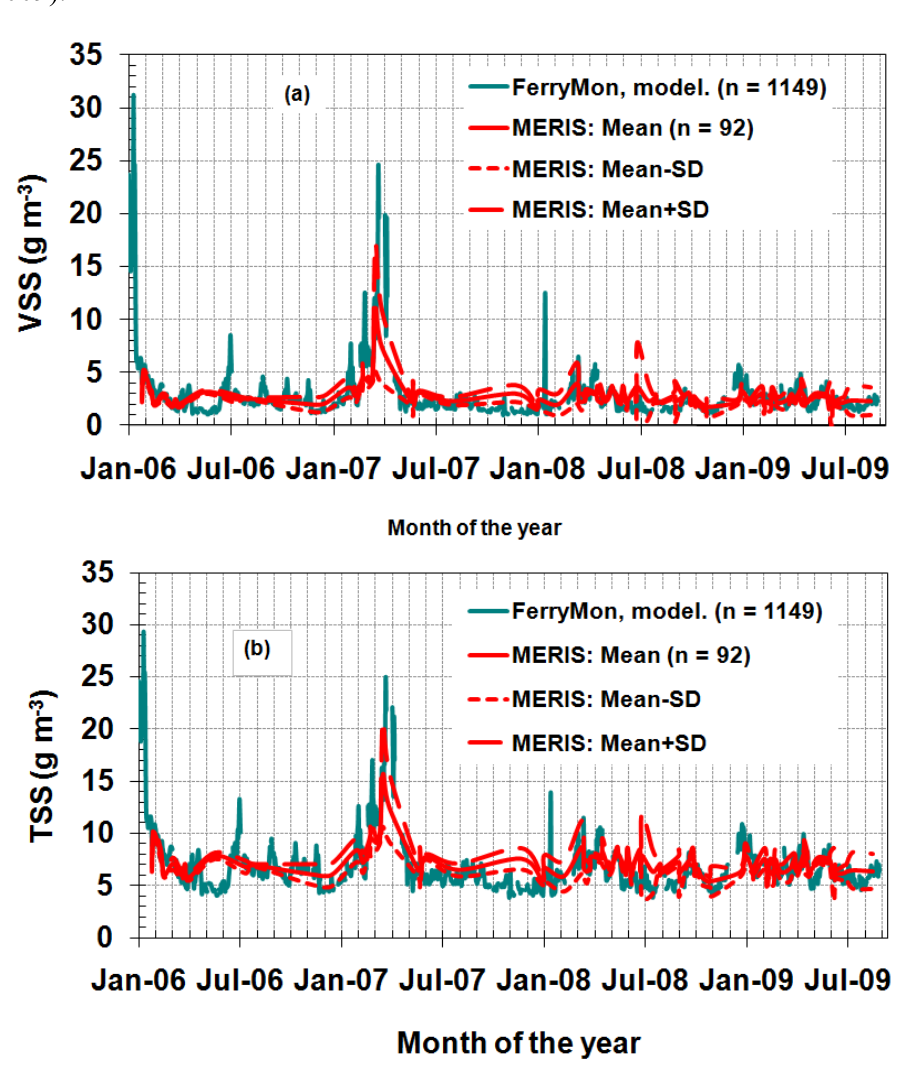
Figure 6. Daily-averaged values for volatile suspended solids (VSS) (a) and total suspended solids (TSS) (b) predicted from FerryMon and MERIS for the NRE